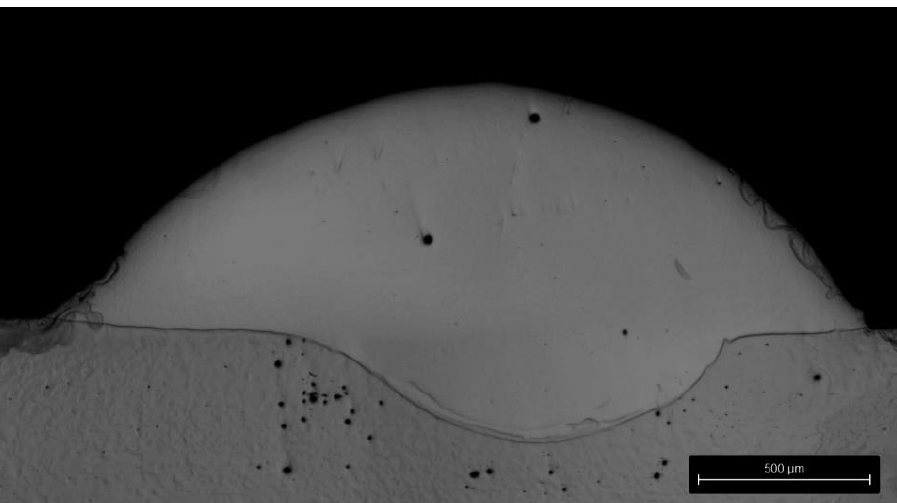
Figure 5. Cross-section cladded using experimental setup 1 and 2400 W laser power, 24 g/min powder feed rate, and 2 m/min scan velocity. Grinding with SiC-paper, polishing with 3 μm diamond suspension, and fine polishing with 0.05 μm colloidal silica.